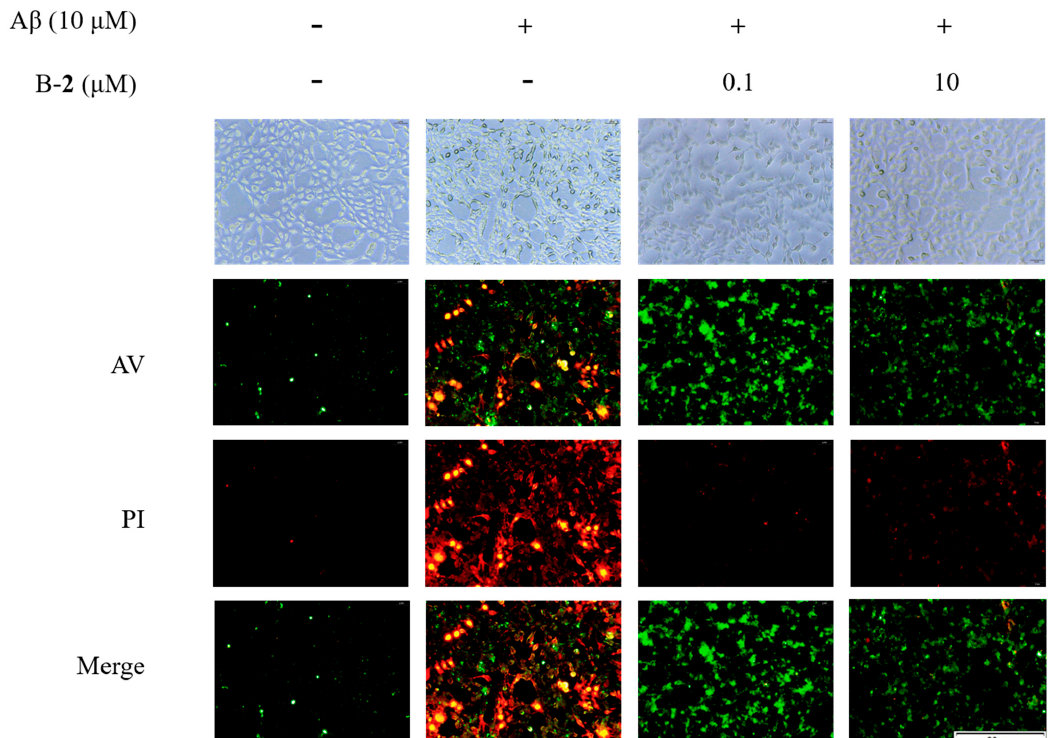
Figure 8. Cell cycle and apoptosis of HT − 22 cells treated by benzaldehydes 2 . Data are expressed as the means ± SD ( n = 3). the means ± SD ( n =